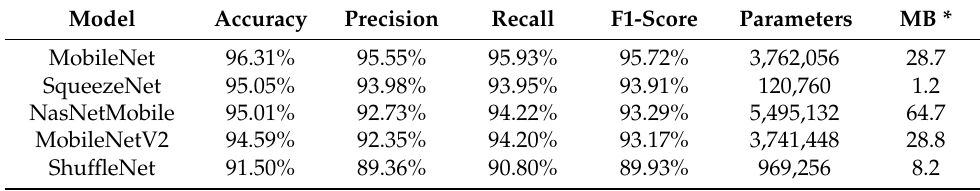
Table 4. Metrics obtained from the confusion matrix (Macro Avg).